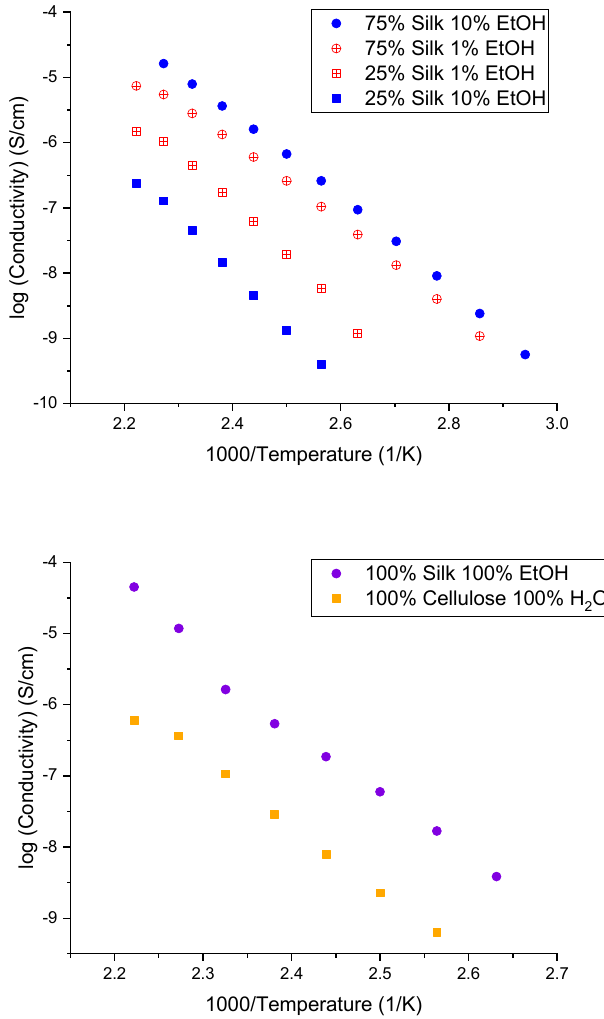
Figure 8. Ionic conductivity versus temperature of the two sets of varied composition silk/cellulose biocomposites as well as 100% regenerated silk, and 100% regenerated cellulose samples.